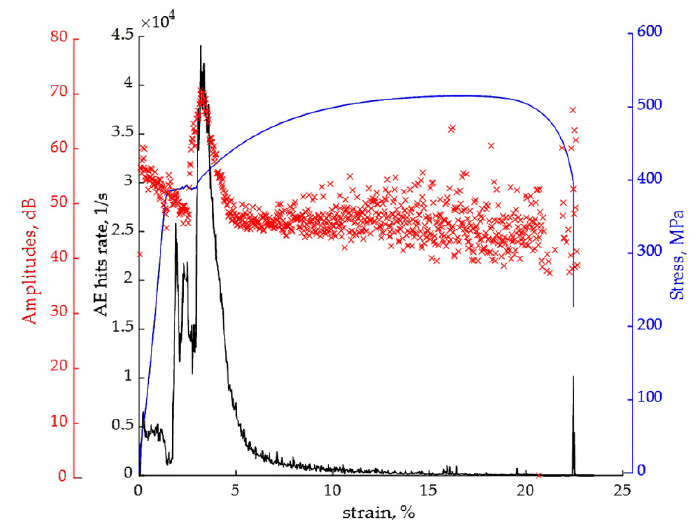
Figure 4. AE data recorded under tension of specimens made of 09G2S low-alloyed pearlitic